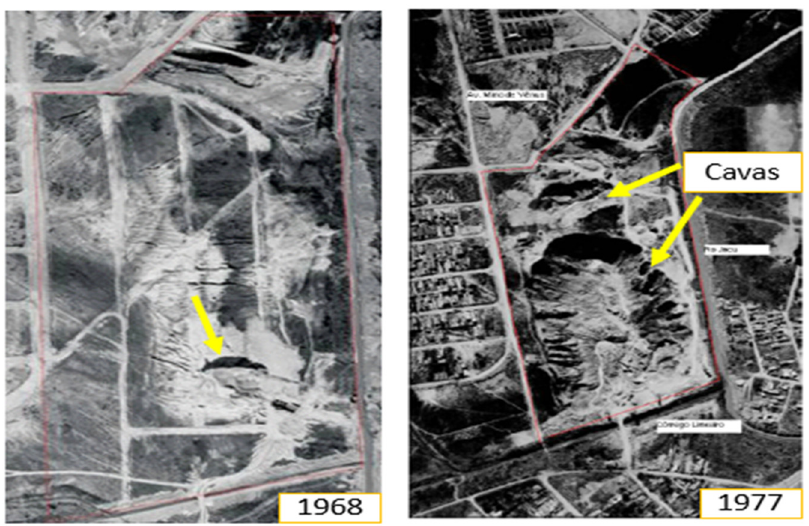
Figure 3. Pit formation in 1968 and 1977. Municipal Park Jardim Primavera [18].